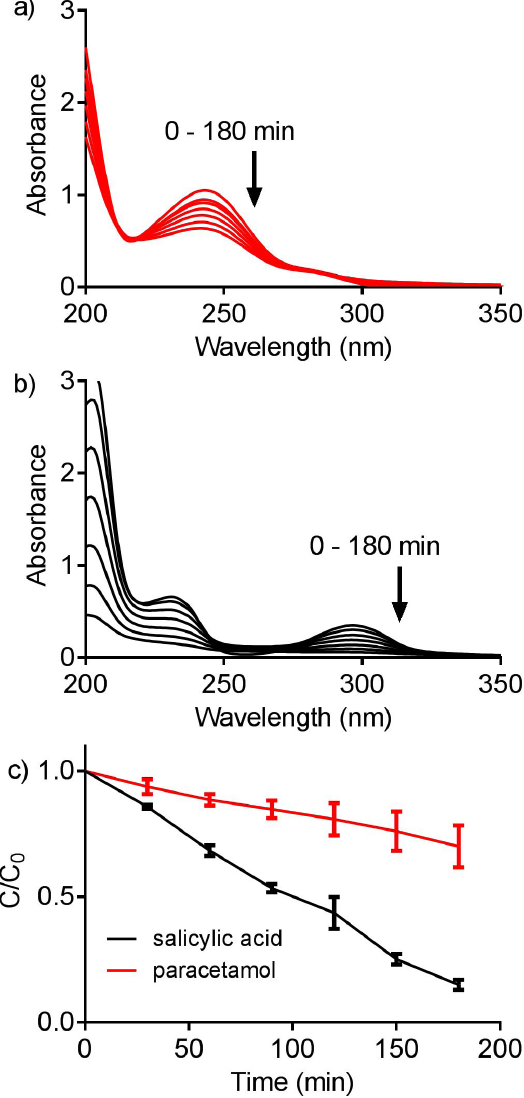
Figure 1. UVC-promoted degradation of (a) paracetamol (100 μmol L -1 ) and (b) salicylic acid (100 μmol L -1 ) catalyzed by TiO the aqueous medium (25 mL) at 25°C. The results (c) are expressed as means and SD of three experiments. band centered at 240 nm, while salicylic acid absorbs at 295 nm (Figure 1). Therefore, if present and relevant, the light filter effect elicited by salicylic acid and paracetamol